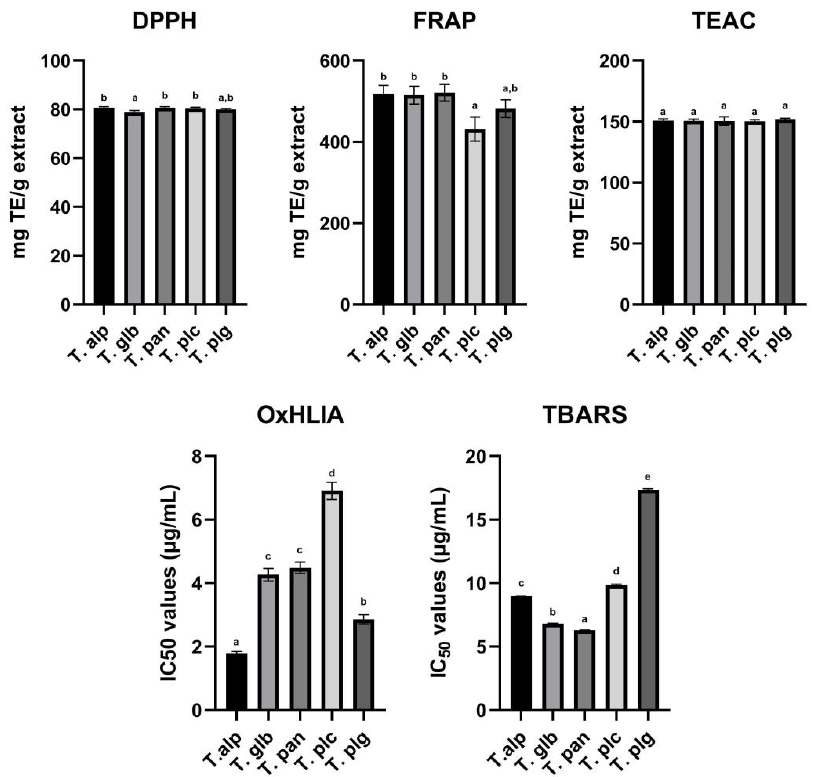
Figure 2. Results of the in vitro antioxidant capacity of Thymus species studied through DPPH, FRAP, TEAC, OxHLIA and TBARS assays. The results are expressed as average ± standard deviation of three parallel measurements. Statistical differences were assessed by one-way ANOVA, followed by Tukey’s HSD post hoc test ( α = 0.05). Different lower-case letters indicate significant differences